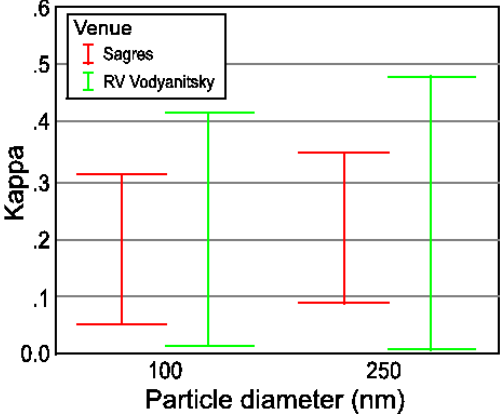
Figure 5. Variability in aerosol hygroscopicity for particles of the same size. Fig. 5. Variability in aerosol hygroscopicity for particles of the same Observations are in marine air in the Eastern Atlantic and are from Swietliki et al size. Observations are in marine air in the Eastern Atlantic and are (2000). The error bars represent the range of the measured values. from Swietliki et al. (2000). The error bars represent the range of the measured